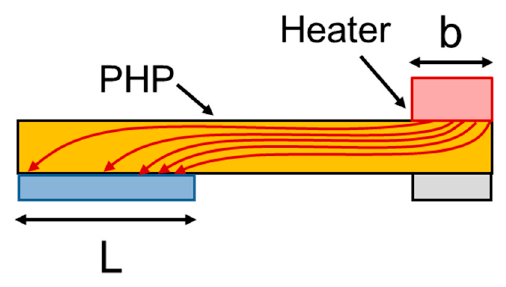
Figure 10. Schematic illustration of heat flow (red lines) in a PHP with a heater (width b) and a condenser plate (width 𝐿 ).